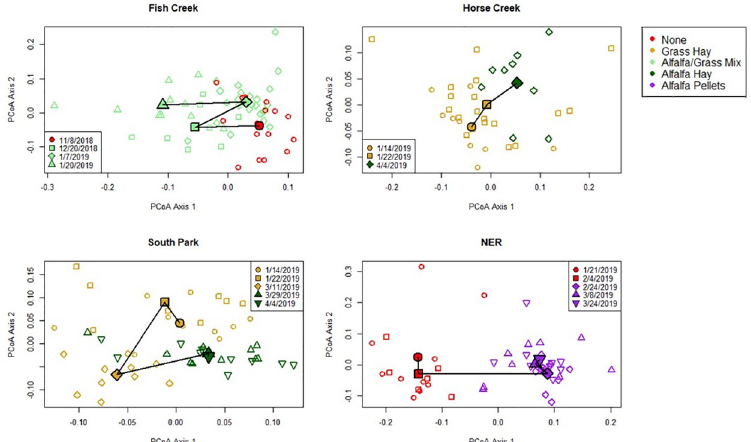
Fig 5. Principal coordinate analysis plots of gut microbiome samples from populations that underwent mid- season shifts in feeding regime over the course of the study. Principal coordinate analysis was performed on Bray- Curtis distances separately for each population, therefore axes do not represent the same dimensions for each plot. Individual samples are represented by unfilled symbols, and population centroids for each time point are represented by filled symbols. Color represents feed regime, and shape indicates sample date. Centroids for each sampling date are connected in temporal order with solid lines to highlight compositional shifts over time.